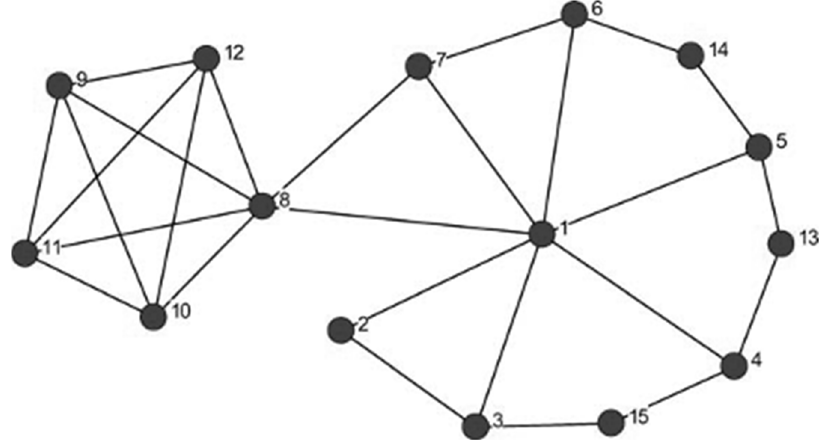
Figure 3. Node 8 is a key player in this network because the removal of that node results in the disconnection of the network (i.e., instead of there being the single component depicted above, two smaller components are